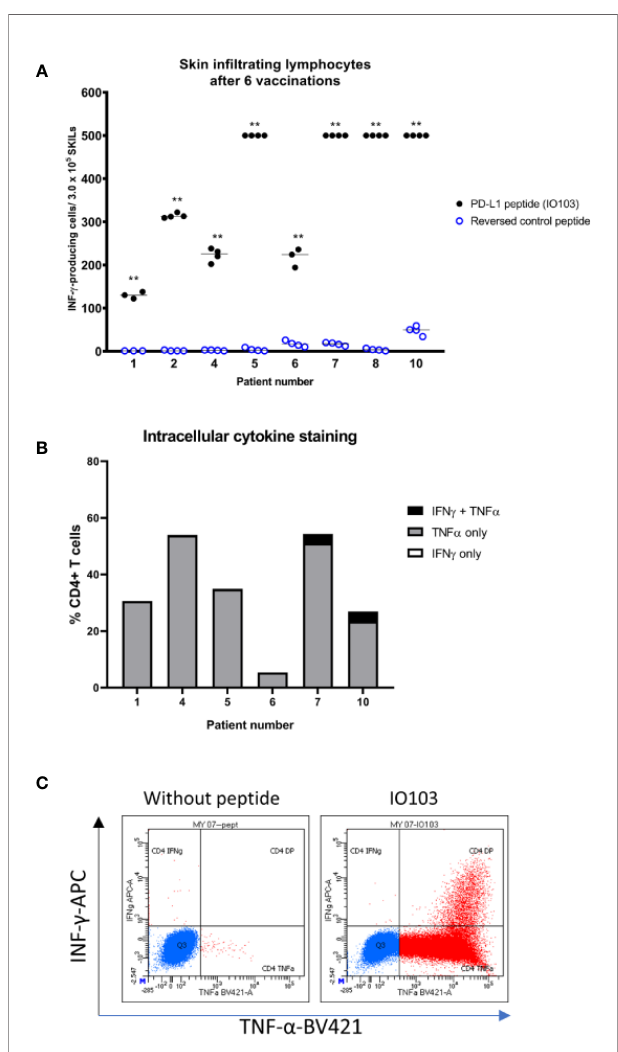
FIGURE 2 | Immune responses to the vaccine in the skin. (A) IFN g -ELISPOT responses against the PD-L1 peptide IO103 of skin in fi ltrating lymphocytes after delayed type hypersensitivity reaction performed after 6 vaccines. 300,000 cells per well. Samples were run in triplicate or quadruplicate. **DFRx2; (B) intracellular cytokine staining (ICS) of SKILs. Almost all cells were CD4+ (not shown). Two out of six evaluable patients had TNF a - and INF g - double positive SKILs; (C) example of a double positive ICS (patient